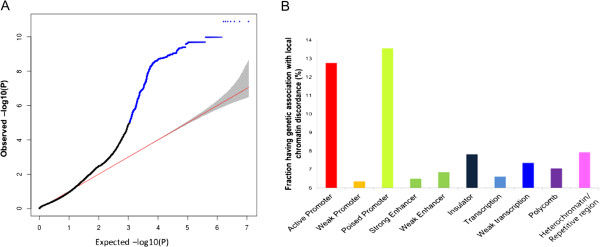
Interplay between genetic and non-genetic factors causing chromatin discordance. (A) Quantile-quantile plot of P values for local (<1 Mb) associations from the QTL mapping of chromatin discordance. The 5th and 95th percentiles of the beta distribution of the P values is shown (gray shading). Significant associations (FDR = 0.01) are denoted in blue. (B) The percentage of chromatin-state domains harboring the chromatin regions that are discordant depending on a local genotype. The number of such domains was divided by the total number of the domains containing the open chromatin regions used in our QTL mapping.